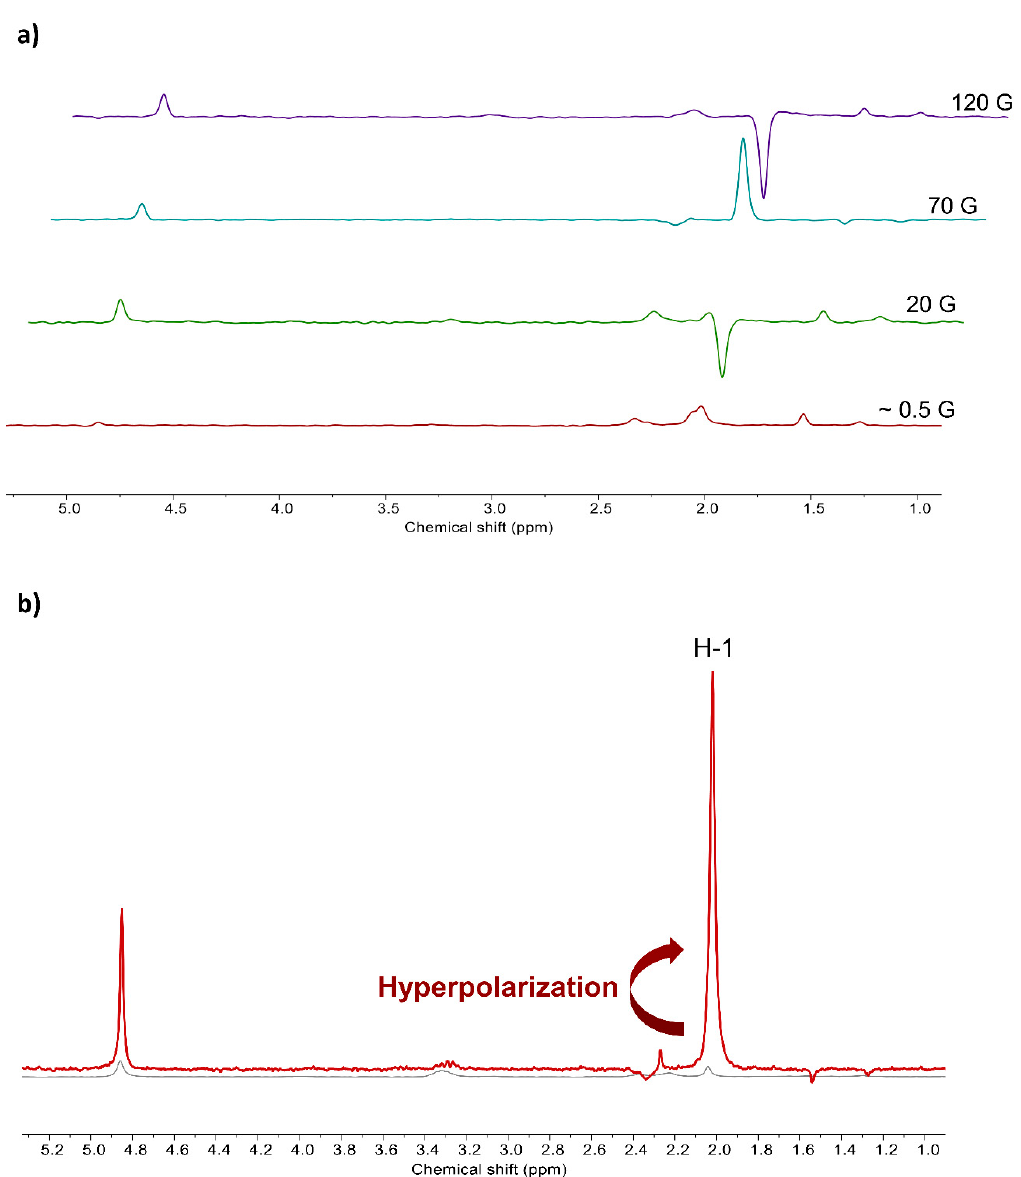
Figure 3. NMR spectrum after SABRE in di ff erent magnetic fields on the 1 µ L (19 µ mol) of acetonitrile ( a ) and hyperpolarized spectrum in 70 G ( b ) All other examples of spectra are shown in Supplementary